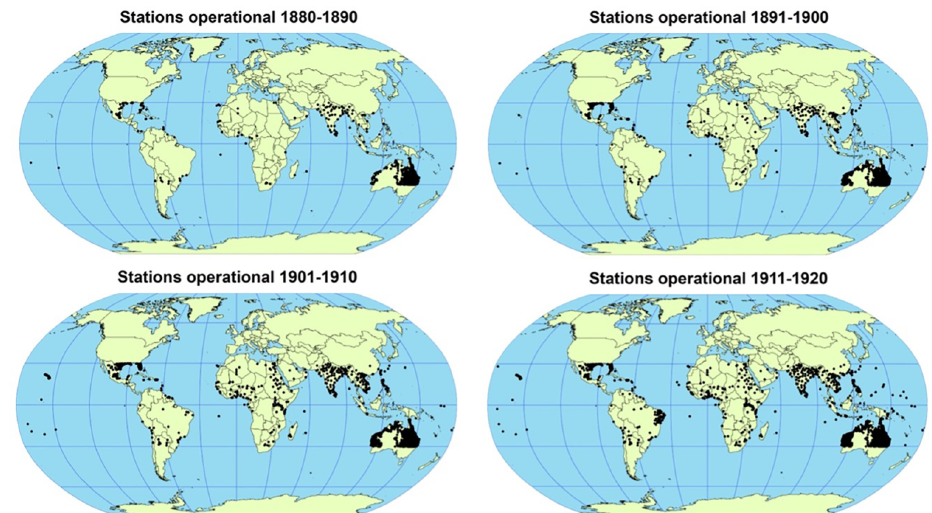
Figure 2. Available monthly resolution temperature records between 30 ◦ N and 30 ◦ S over the period around the parallel measurement experiment analysed herein arising from the international efforts of the Copernicus Climate Change Service and NOAA’s National Centers for Environmental Information (Thorne et al., 2017; Noone et al., 2021). Note that, to date, only non-continuous digitized data for Mauritius at Pamplemousses 1787–1974 are available in international